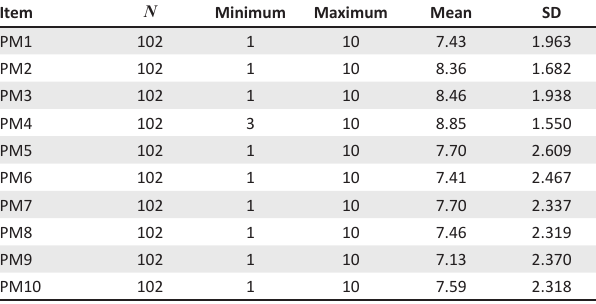
TABLE 8: Descriptive statistical analysis (Section B – working alone). Item